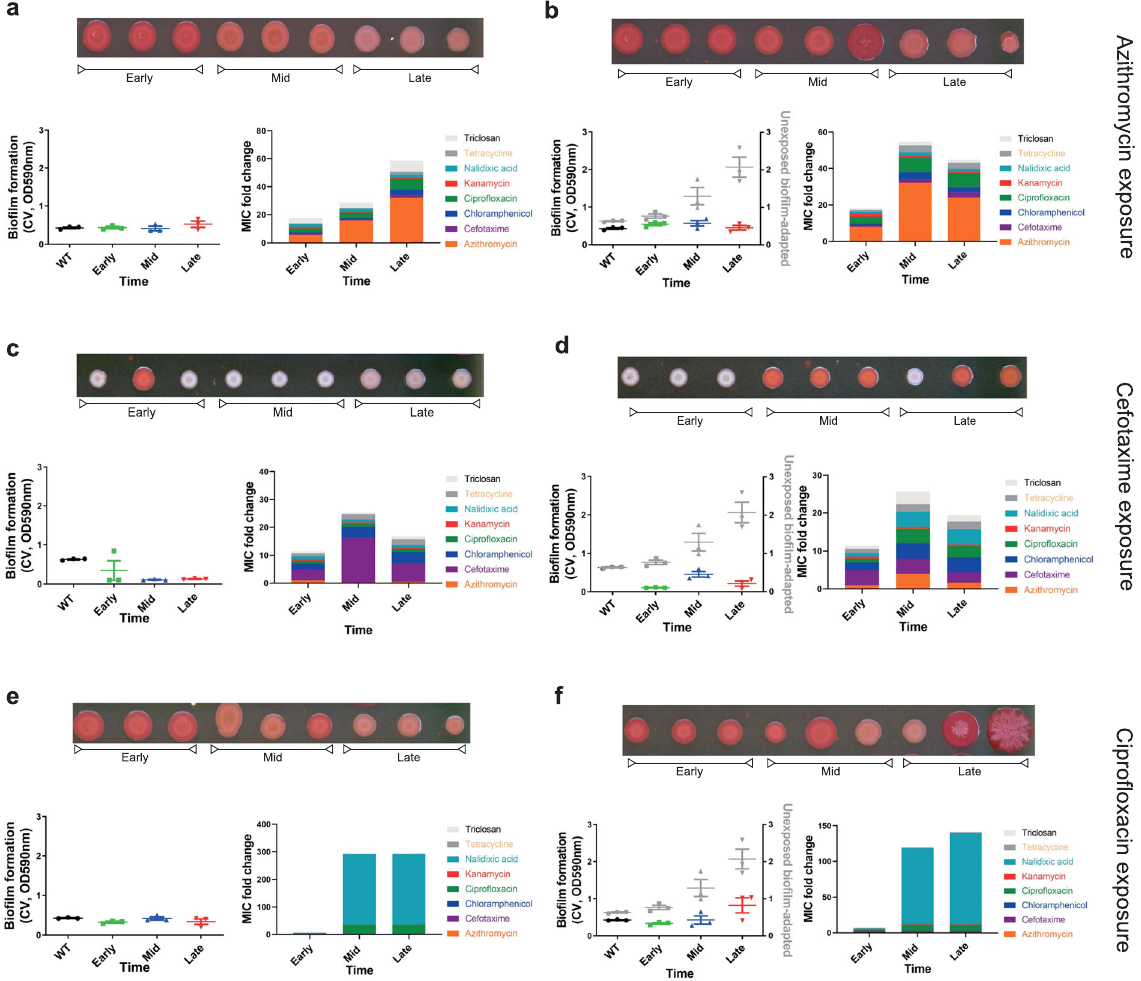
Fig. 3 Bio fi lms adapt to antibiotic stress, with diverse effects on bio fi lm formation. Planktonic and bio fi lm populations, exposed to azithromycin ( a , b ), cefotaxime ( c , d ) and cipro fl oxacin ( e , f ) were isolated at different timepoints during the evolution experiment (early, mid and late). Panels on the left show data from planktonic lineages and panels on the right from bio fi lm lineages. Three single isolates from each condition and timepoint were tested for their bio fi lm ability (measured on three separate occasions, points show the mean for the technical replicates of each repeat) and antibiotic susceptibility. For reference, bio fi lm formation data from isolates from control experiments with no drug exposure is overlaid on the crystal violet graphs to allow comparison (grey points on each graph). Antibiotic susceptibility of a panel of different antimicrobials was determined and visualised by stacking the average MICs (from three independent isolates per condition) for each antibiotic. All lineages, exposed to azithromycin ( a , b ), developed resistance to azithromycin as well as decreased susceptibility to cefotaxime, chloramphenicol, cipro fl oxacin, nalidixic acid, tetracycline and triclosan. Those isolated from bio fi lms were, however, compromised in bio fi lm formation ( b ). Planktonic lineages, exposed to cefotaxime, developed resistance only to cefotaxime, whereas bio fi lms from the same exposure developed MDR ( c , d ). All lineages exposed to cefotaxime exhibited compromised bio fi lm formation with pale colonies on CR plates. All lineages exposed to cipro fl oxacin ( e , f ) developed cipro fl oxacin resistance and bio fi lm adaptation was delayed compared to the unexposed control